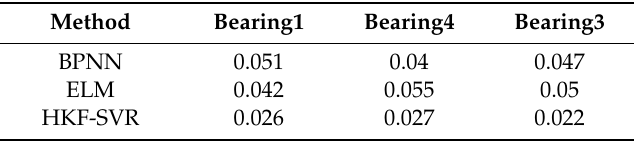
Figure 10. Performance degradation prediction of bearing 4. ( a ) is the result of BPNN, ( b ) is the result of ELM and ( c ) is the result of HKF–SVR with parameters optimized by the KH algorithm Table 5. Prediction errors comparison. Method